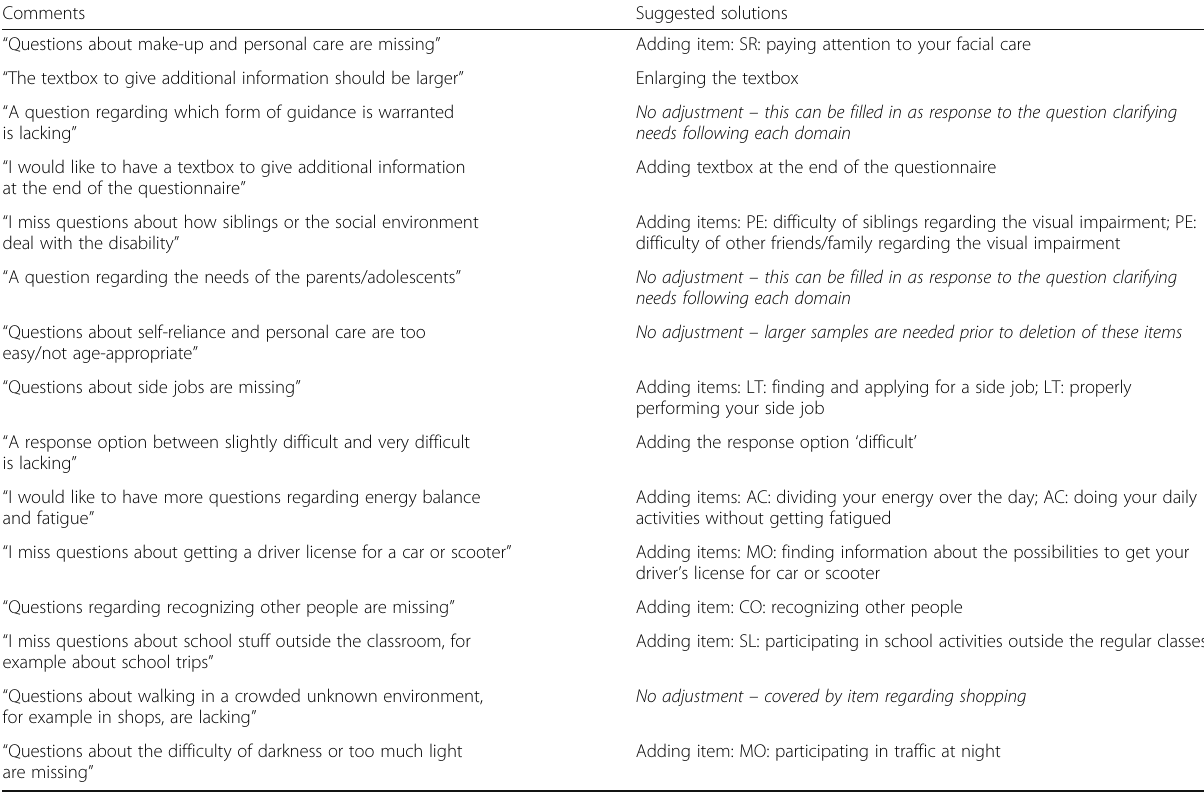
Table 3 Comments of > 1 respondents relevant to the PAI-CY 13 – 17 and suggested